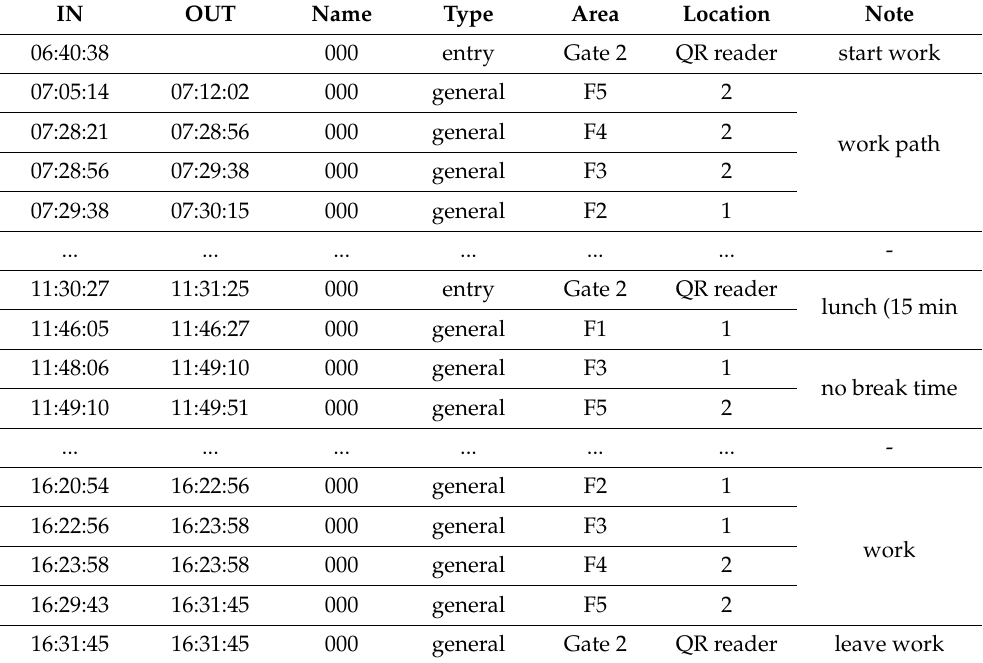
Table 5. Location sensor data for one day for A